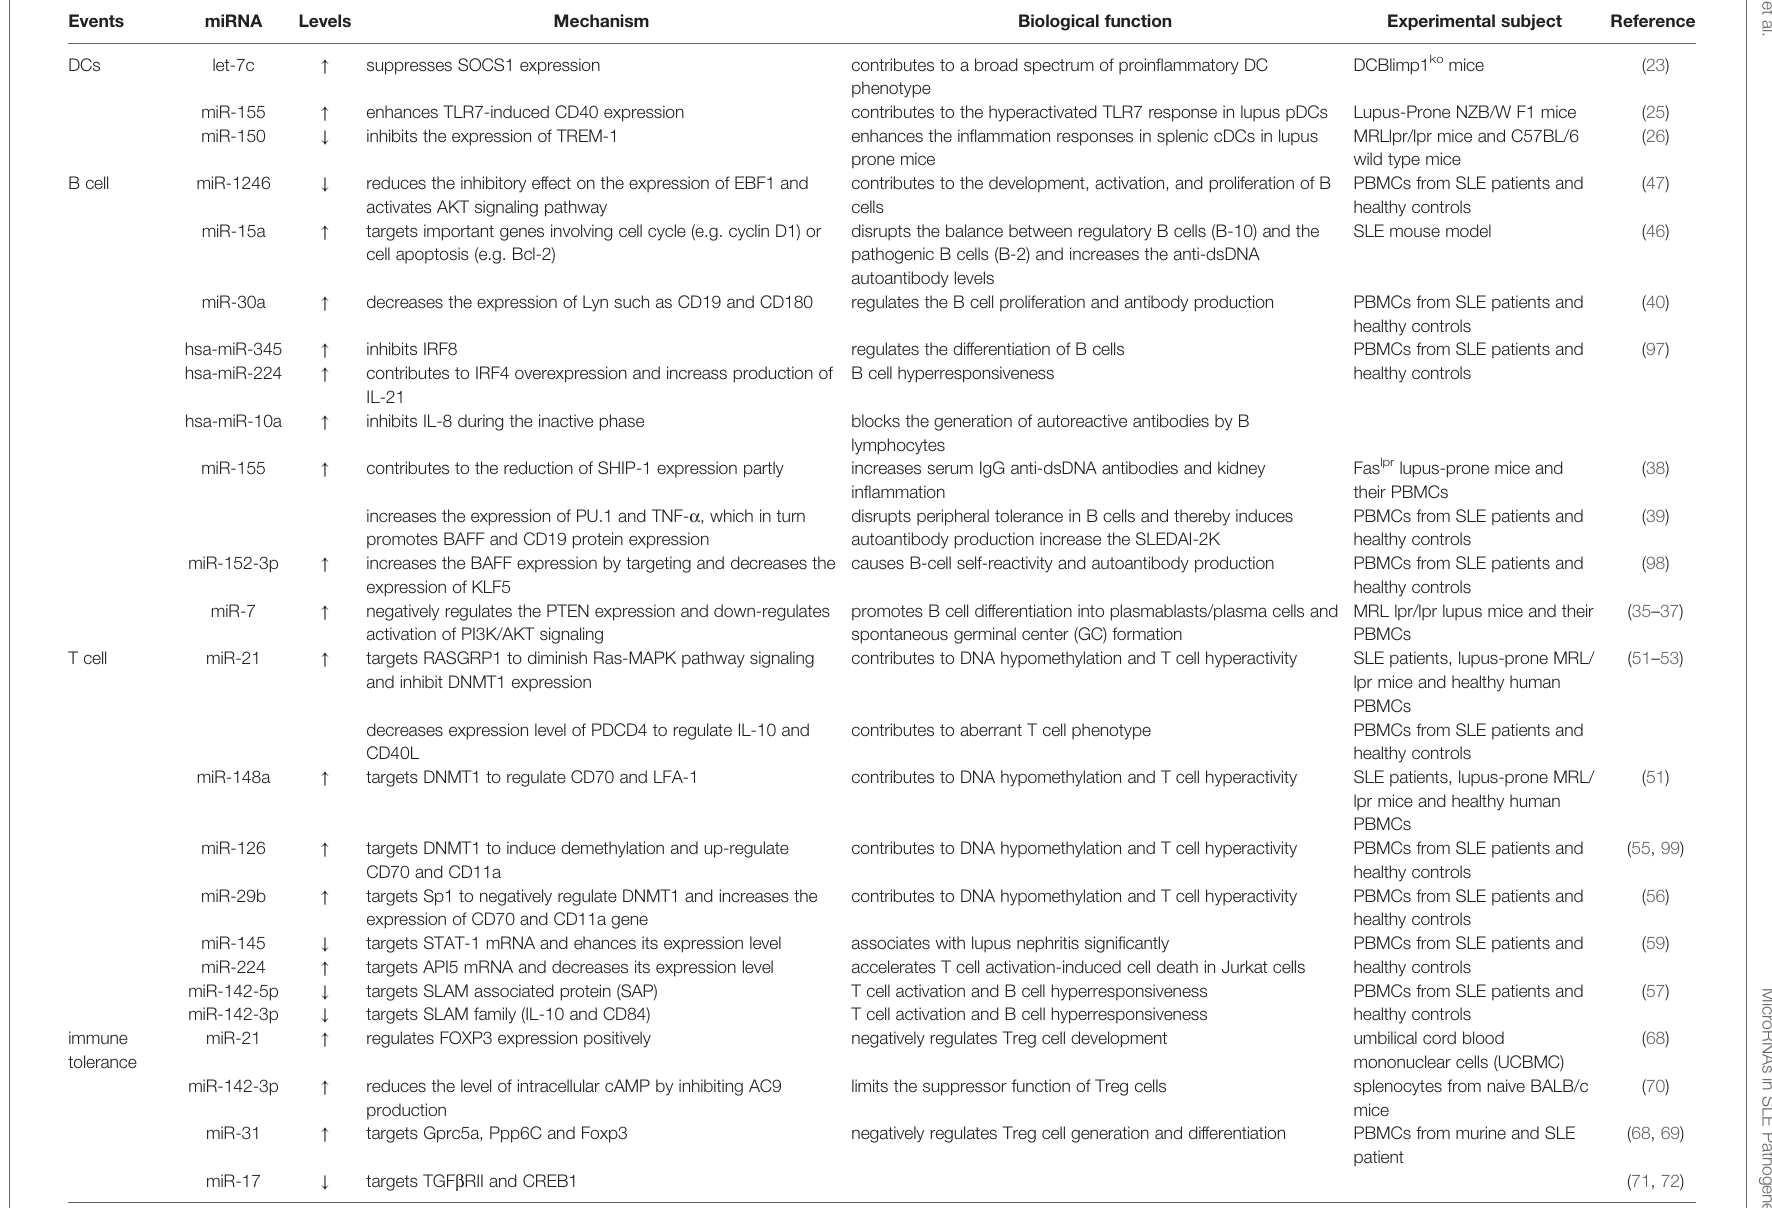
TABLE 1 | The roles of miRNAs in the pathogenesis of SLE.